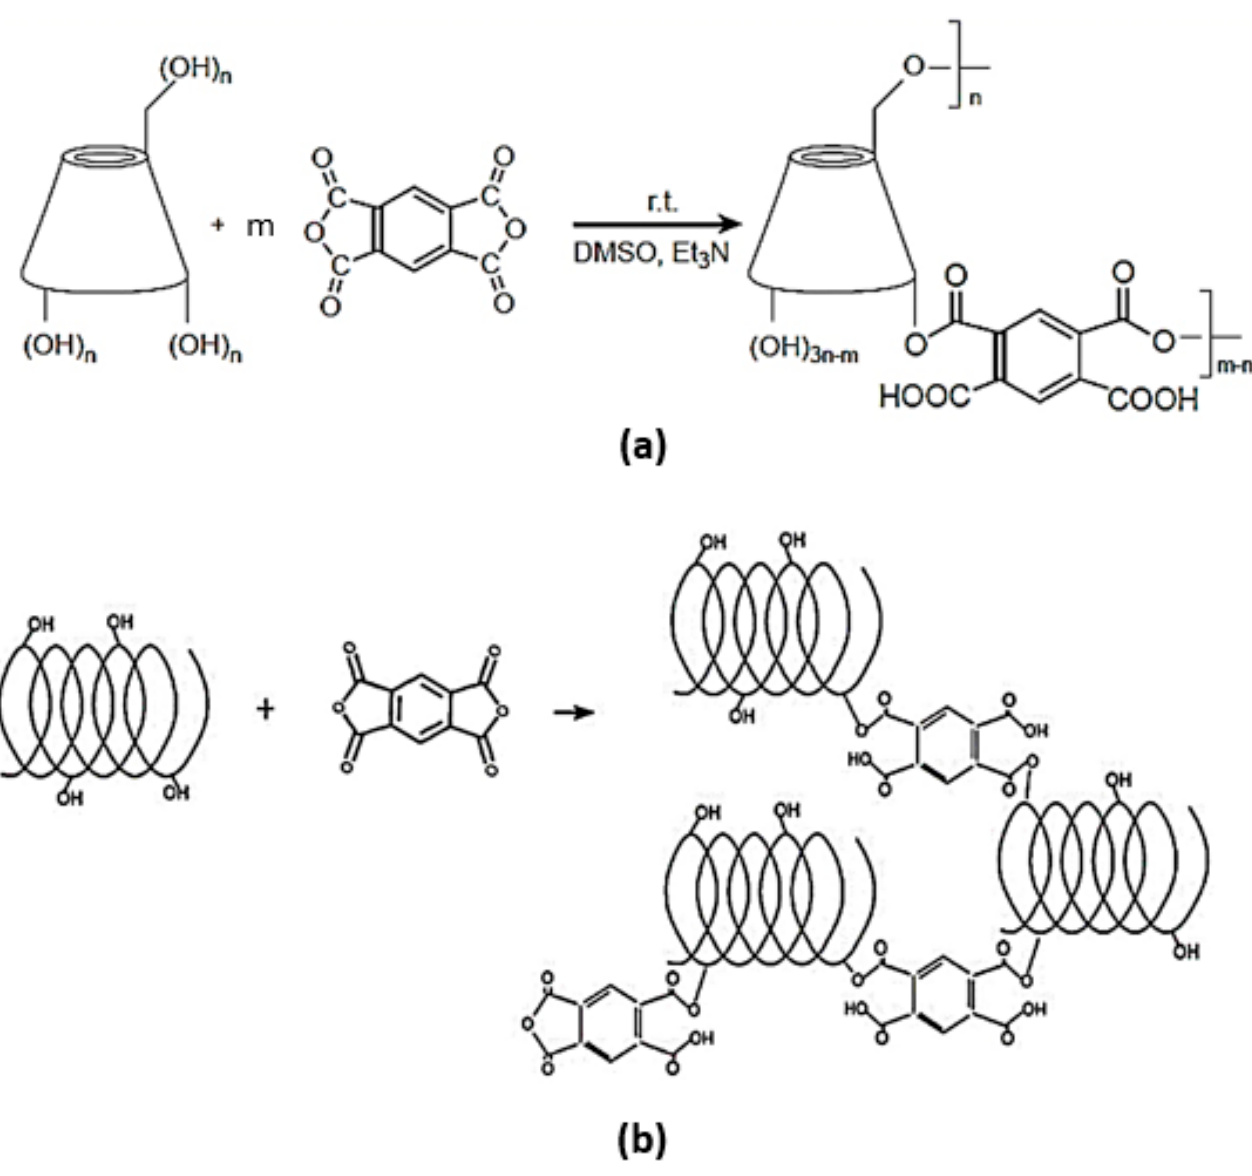
Figure 3. Scheme of the synthetic procedures to obtain ( a ) β -CD PYRO and ( b ) LC PYRO NSs.